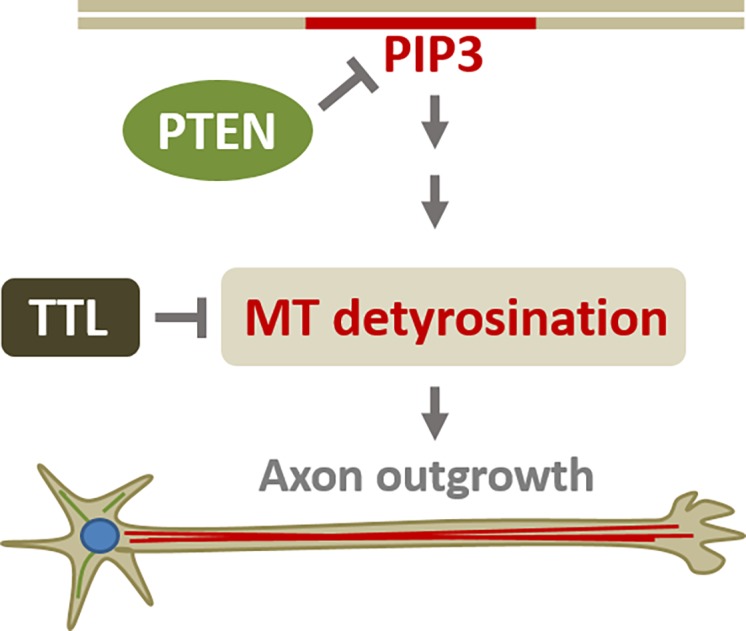
Model of PTEN regulation of axonal outgrowth through detyrosination of microtubules.During steady state conditions, PTEN downregulates the PIP3 (Akt/GSK3β) signaling pathway and that way prevents excessive cell growth. Here, we show that depletion of PTEN leads to an elevated level of stable and detyrosinated microtubules via upregulation of the PIP3 (Akt/GSK3β) pathway. This causes excessive cell growth (i.e. axonal outgrowth) that is prevented by reverting the detyrosination of MTs through overexpression of the tubulin tyrosine ligase (TTL). The plasma membrane is indicated with a grey double line (top) with the PIP3 domain in red. Detyrosinated MTs within the axon of a developing neuron are indicated in red.